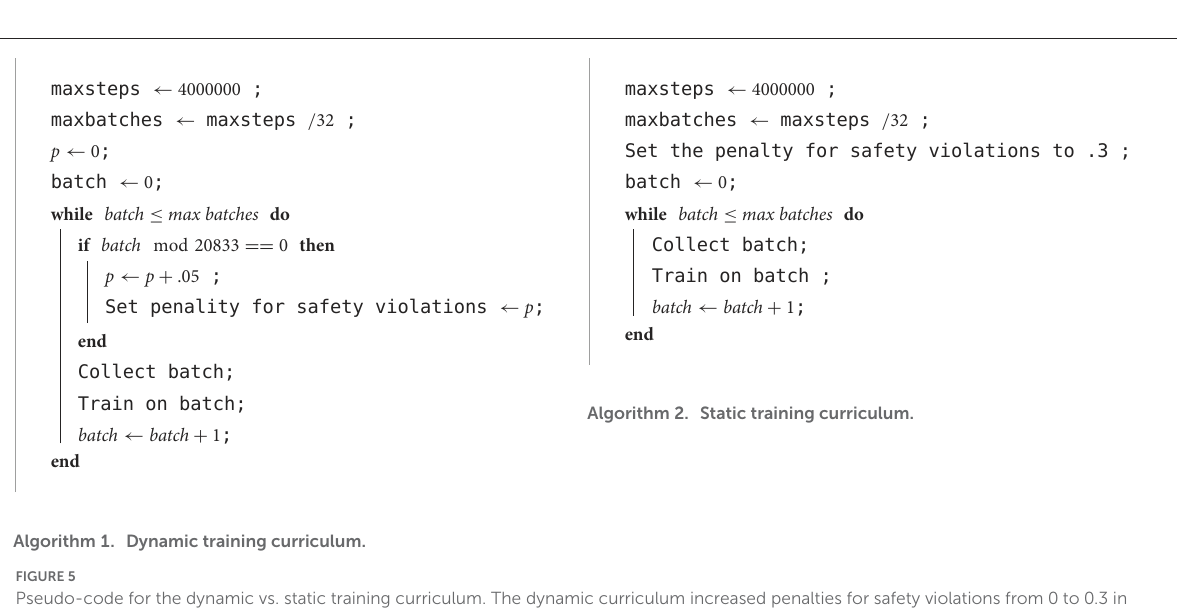
Algorithm 2. Static training